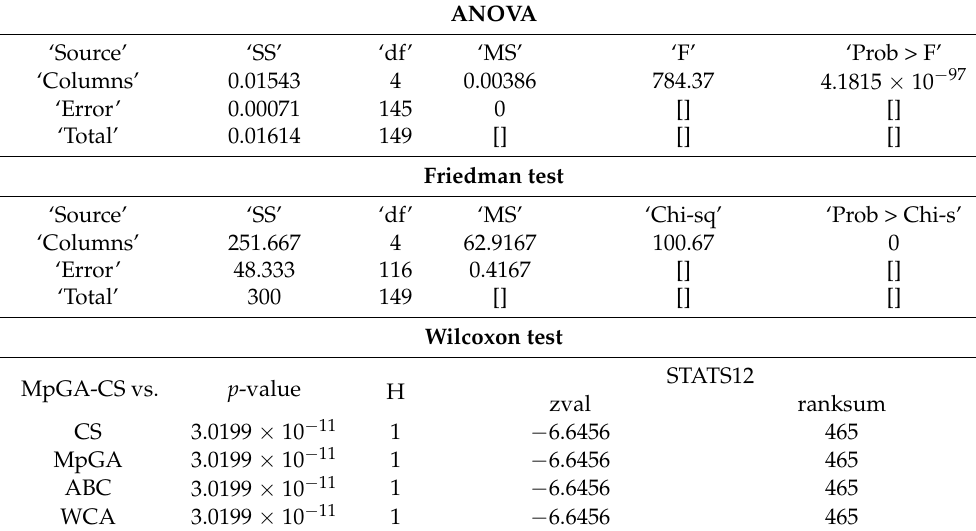
Table 6. Parameter identification of S. cerevisiae results from statistical tests.